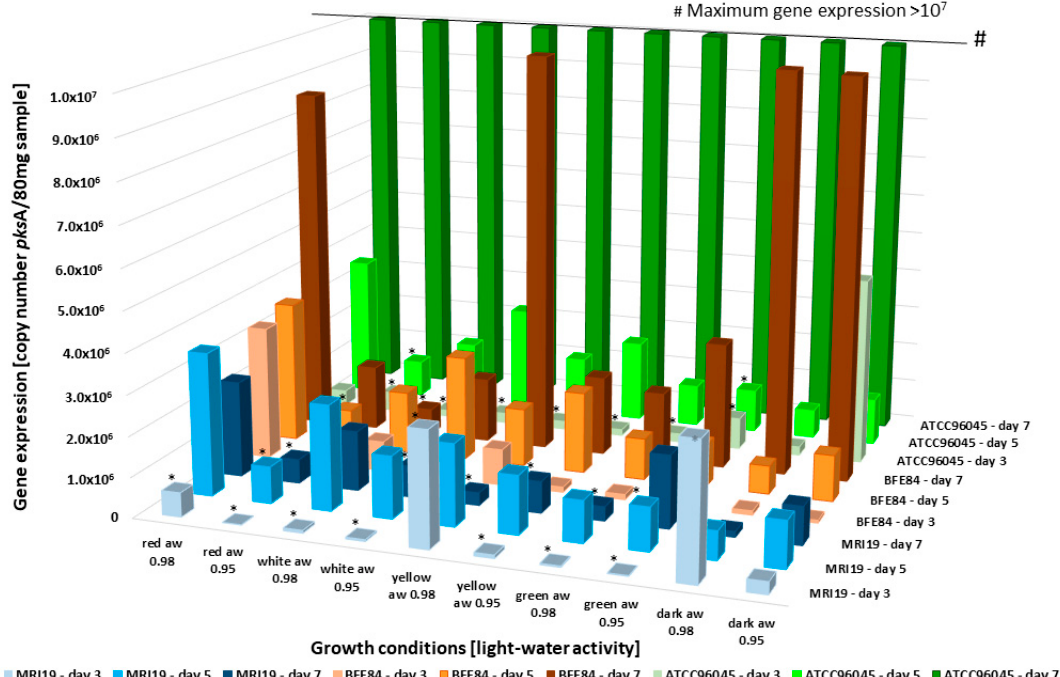
Figure 5. Expression of the pks A gene over 3 days in the analyzed Aspergillus isolates, dependent on di ff erent combinations of light and water activity. * = The gene expression was significantly reduced in relation to the control